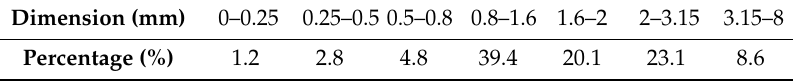
Table 1. Dimensional characteristics of